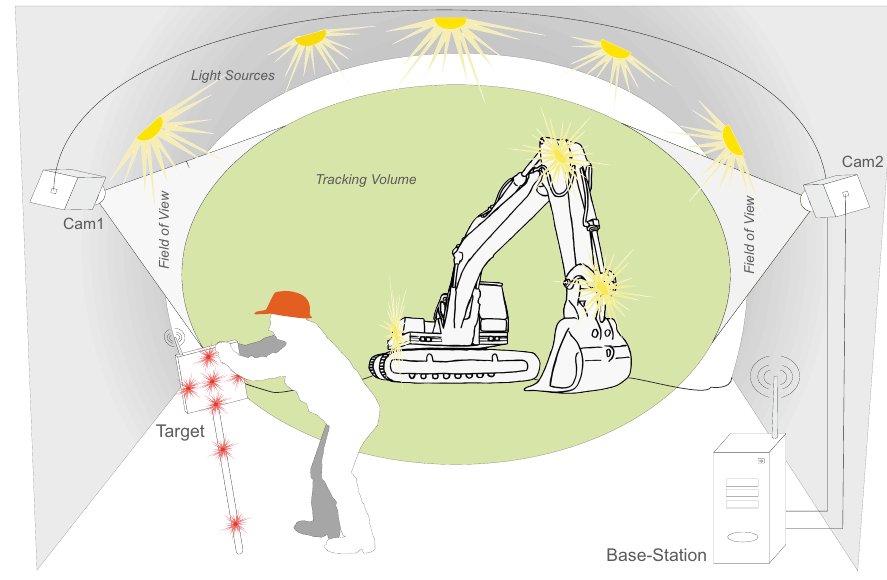
Figure 23. Tracking situation in an underground environment.